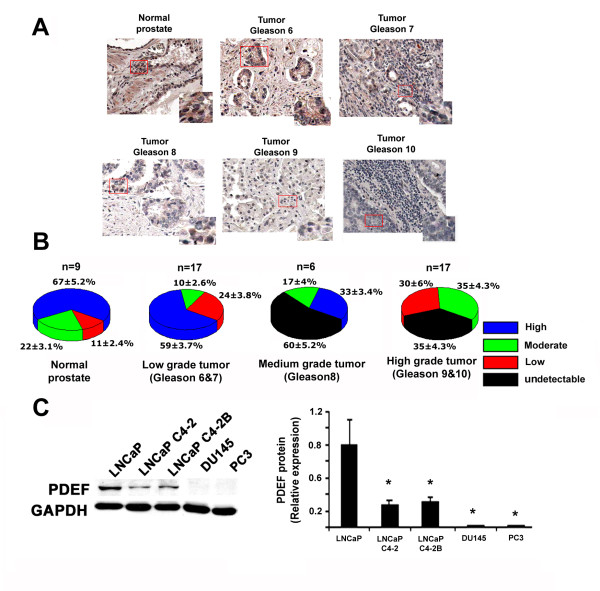
PDEF protein expression in human prostate tissues and prostate cancer cell lines. A, Representative photo-micrographs of Immuno-histochemical analysis of PDEF expression using prostate tissue micro-array slides (containing both normal and tumor samples of different grades) performed as described in Materials and Methods. B, Quantification of percentage staining for PDEF. C, Representative image showing Western blot analysis on prostate cancer cell lines using anti-PDEF antibody (left panel), and quantitation of the same data (right panel).